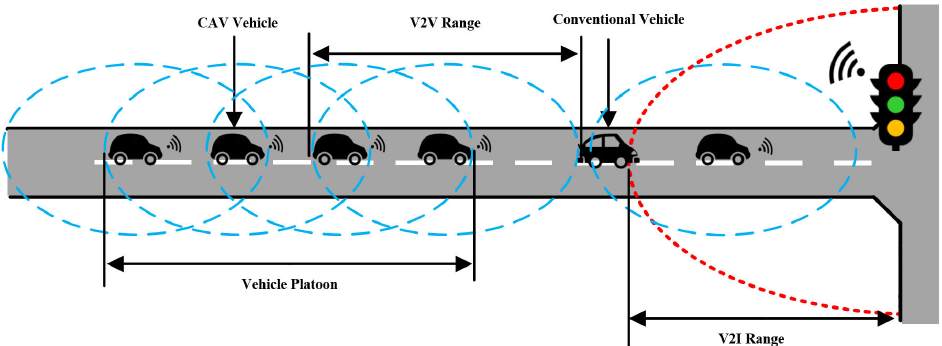
Figure 1. Illustration of the traffic intersection